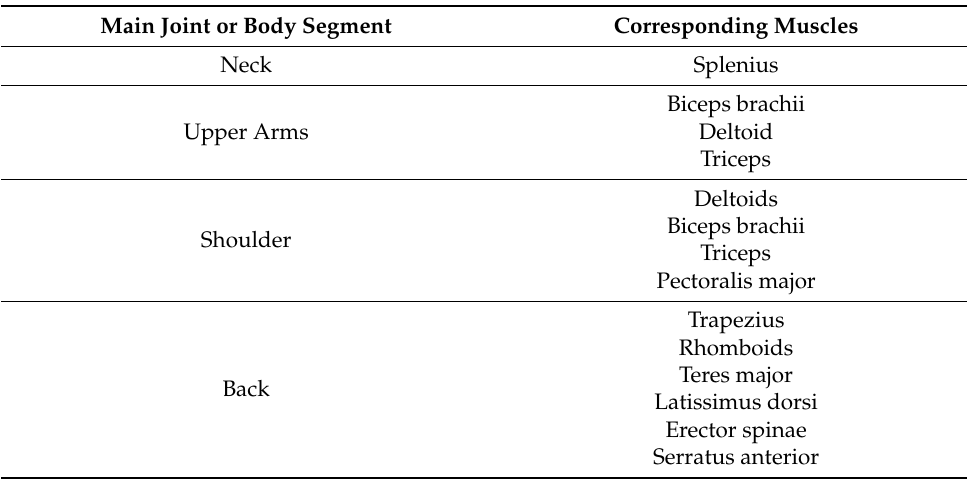
Table 5. Major muscles for body joint and